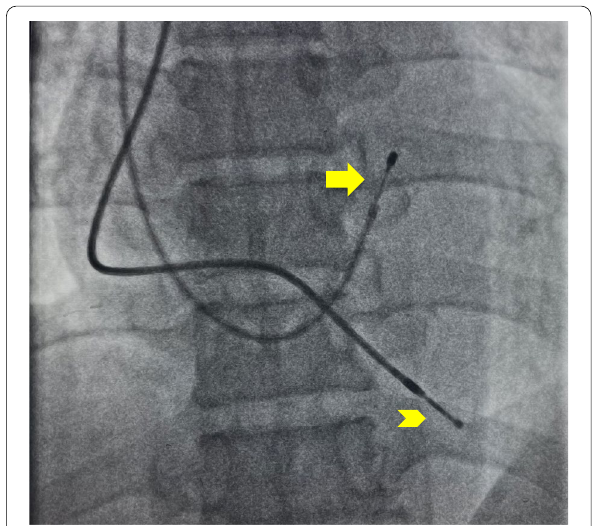
Fig. 1 Temporary pacing lead tip (arrow) abutting Interventricular septum and permanent pacing lead (arrowhead at right ventricular